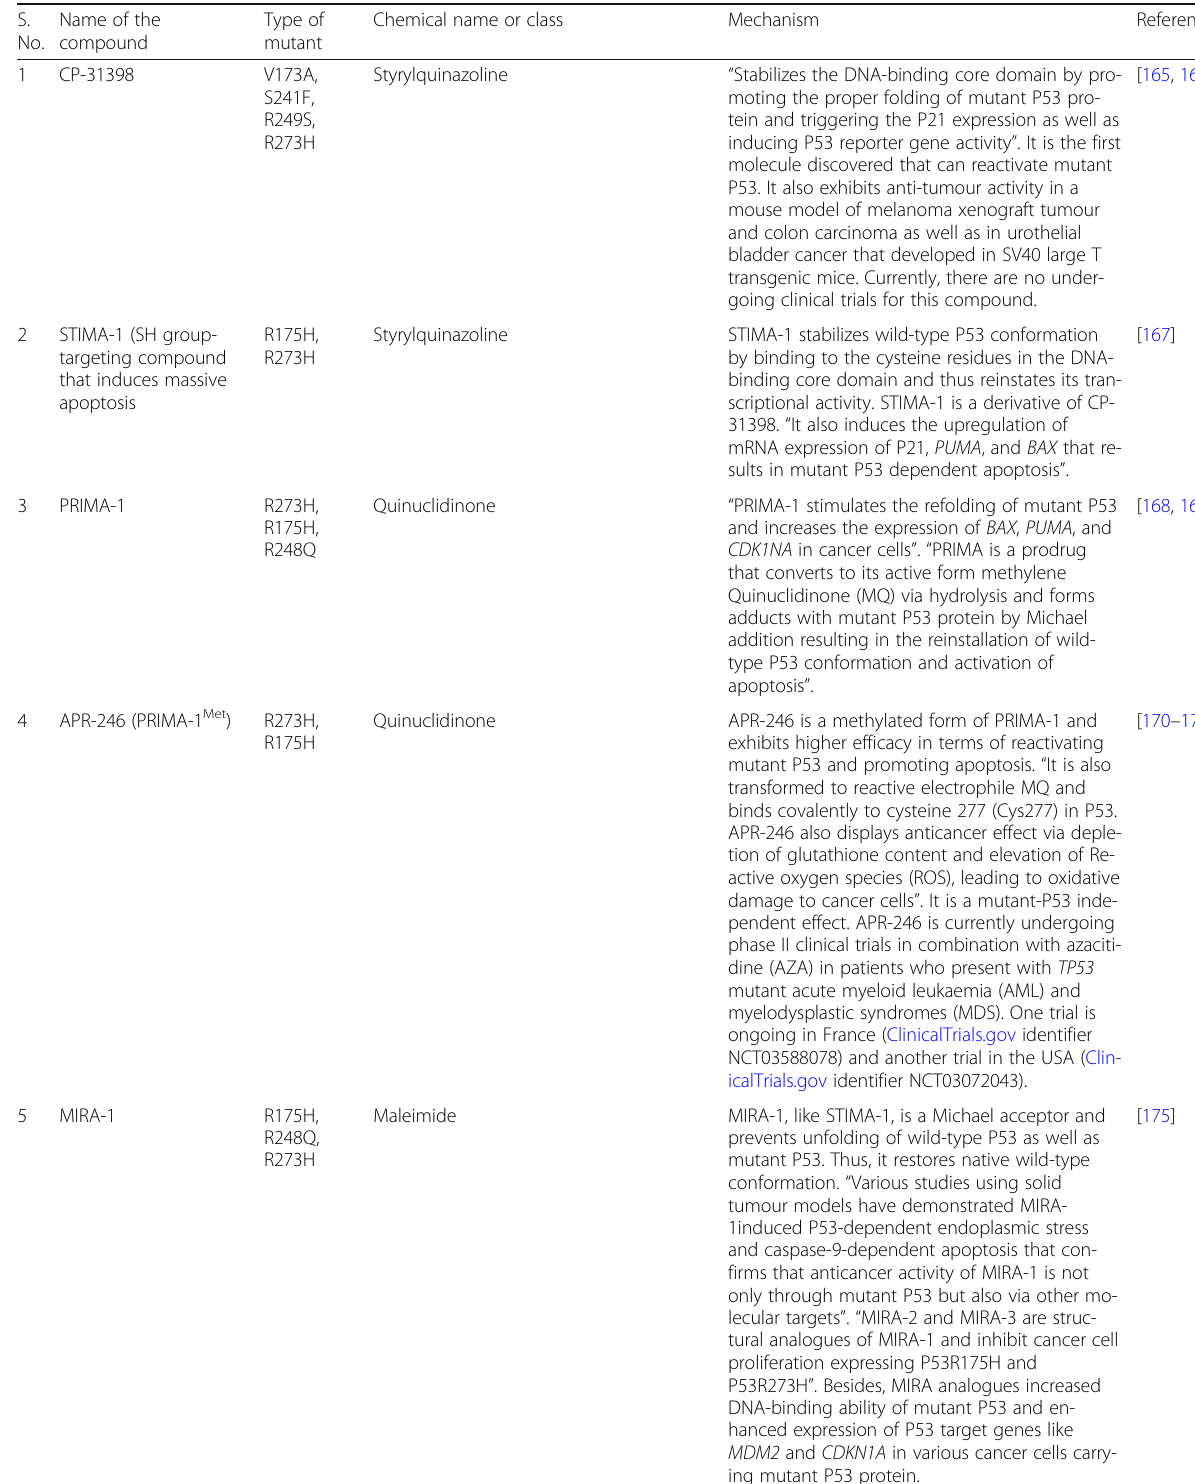
Table 1 Compounds that target mutant P53 and induce